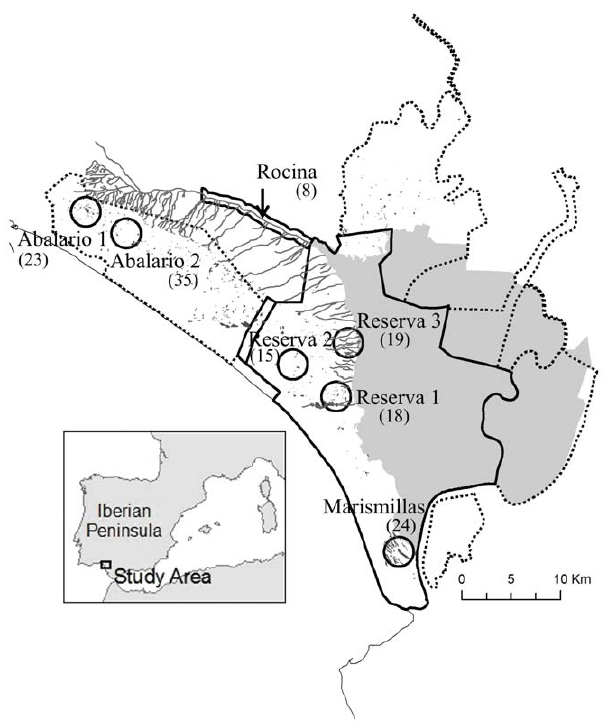
Figure 1. Factorial Correspondence Analysis (FCA) performed with 142 individuals trapped in Don˜ana.